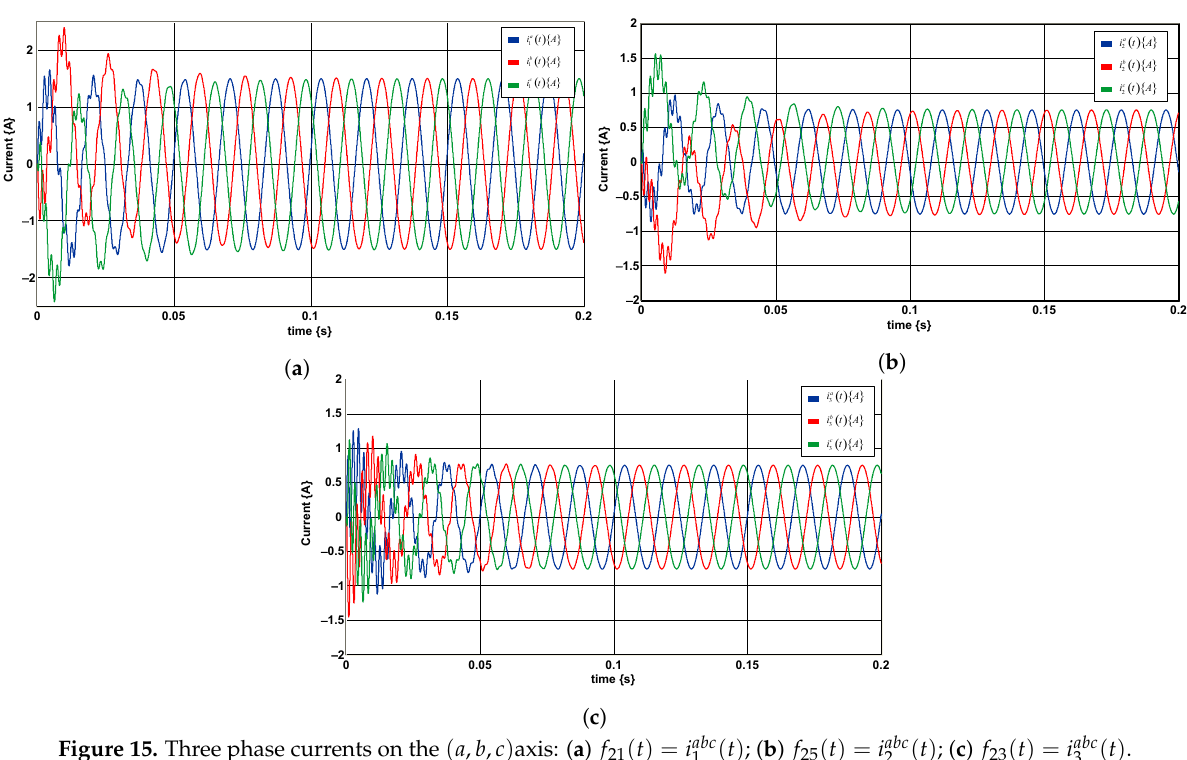
Figure 15. Three phase currents on the ( a , b , c ) axis: ( a ) f 21 ( t ) = i abc